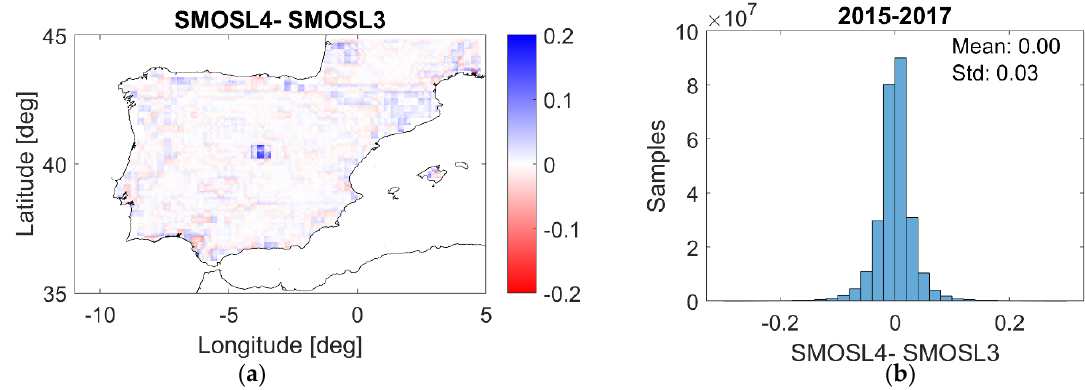
Figure 9. Temporally averaged map ( a ) and histogram ( b ) of daily SMOS SSM differences (SMOSL4 at 1 km minus SMOSL3 at 25 km), for the period April 2015 to December 2017.